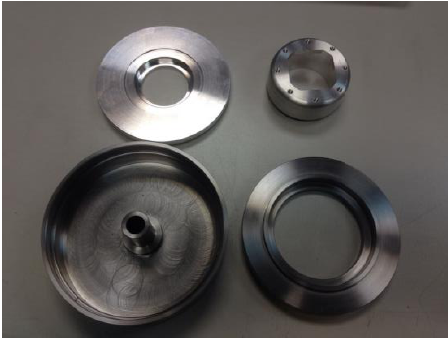
Figure 6. External and internal parts.